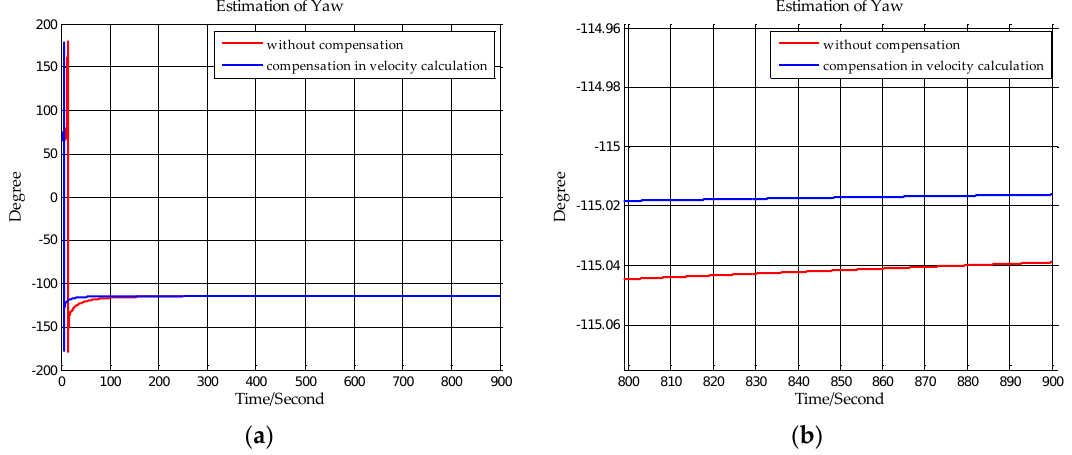
Figure 8. ( a ) is the estimation of pitch with compensation in velocity calculation, and ( b ) is the enlarged view of ( a ) in the last 100 s.